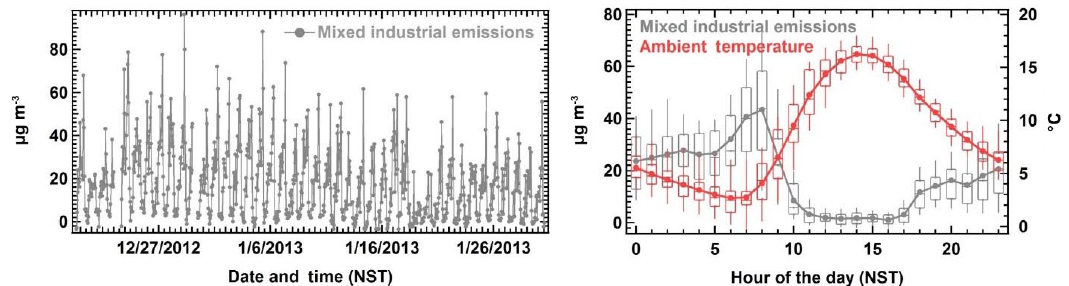
sured NMVOC mass of this factor, but their individual contri- butions were ≤ 5 % each. Overall, Factor 4 explained ∼ 37 % of the total benzene and ∼ 24 % of the total acetonitrile mass